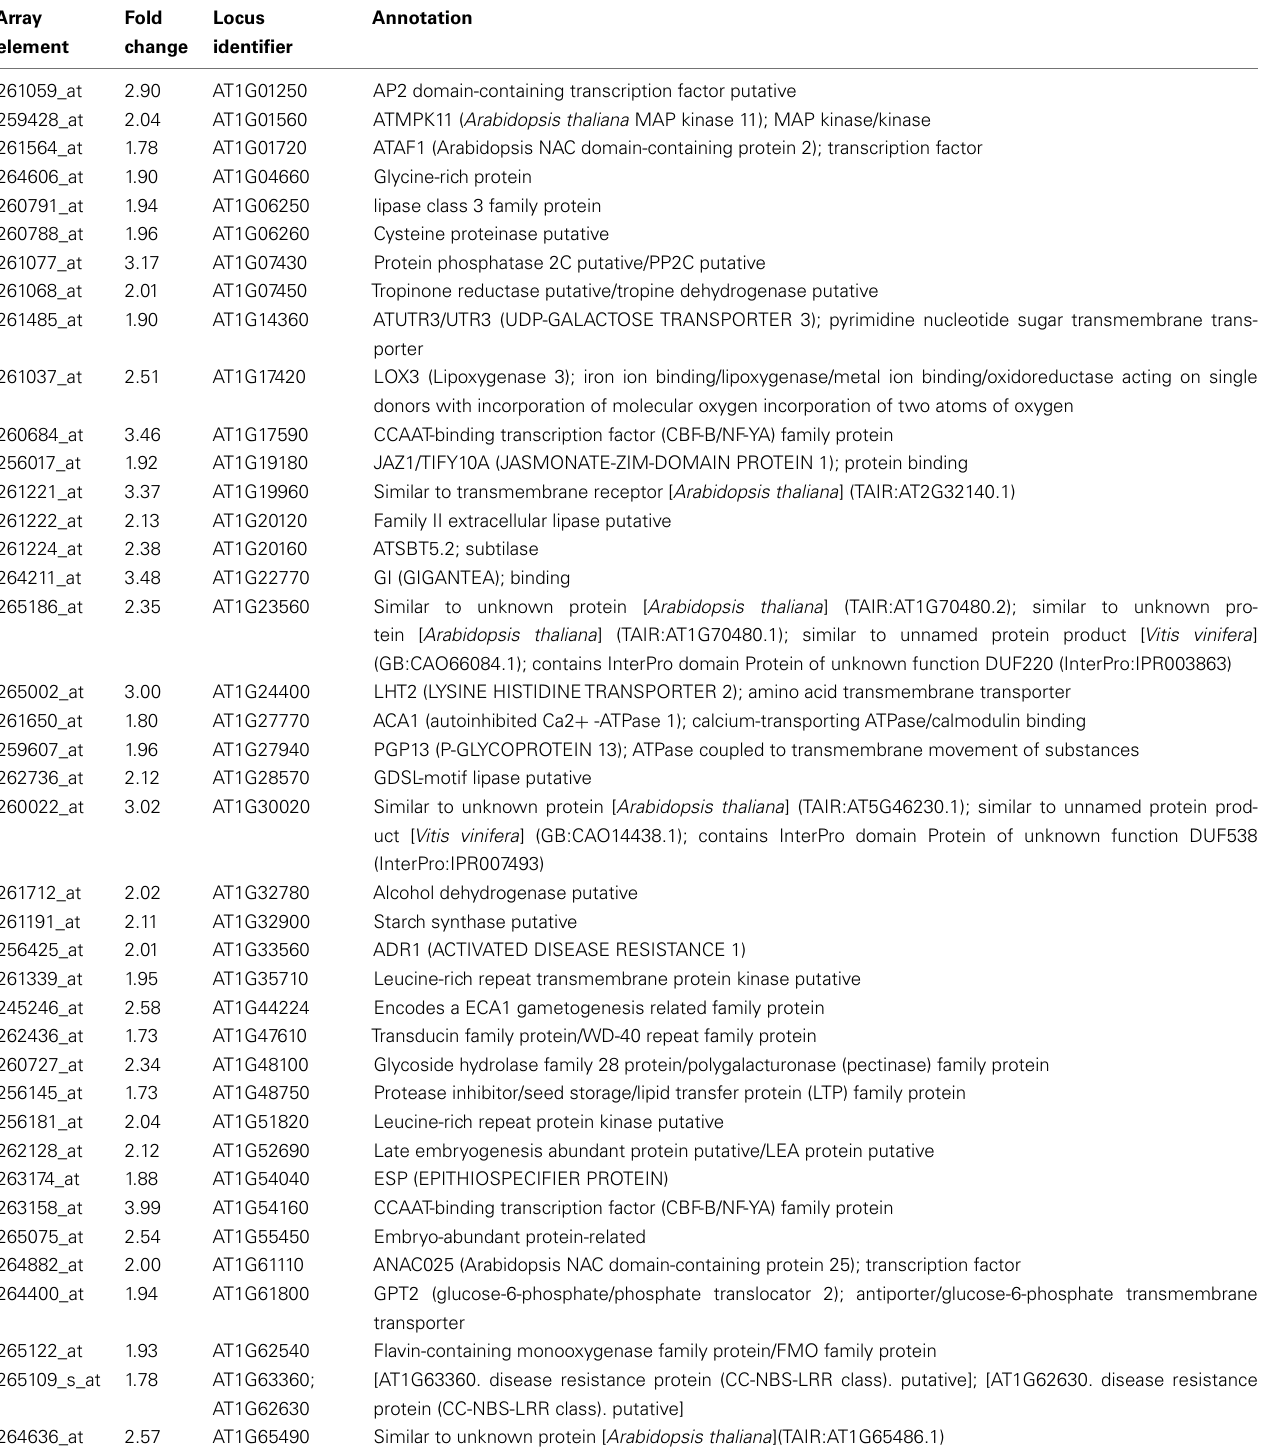
Table 1 | Genes with significantly increased expression in inflorescence apices of pan mutants (Rank Products FDR 0.05). Array